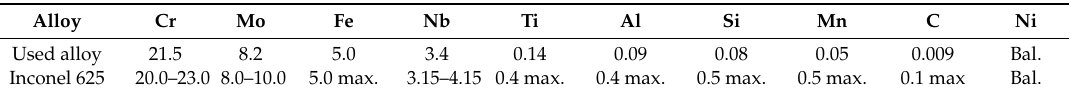
Table 1. Chemical composition of the nickel-based superalloy 625 used in this study and the limiting composition of Inconel 625 in wt. %.